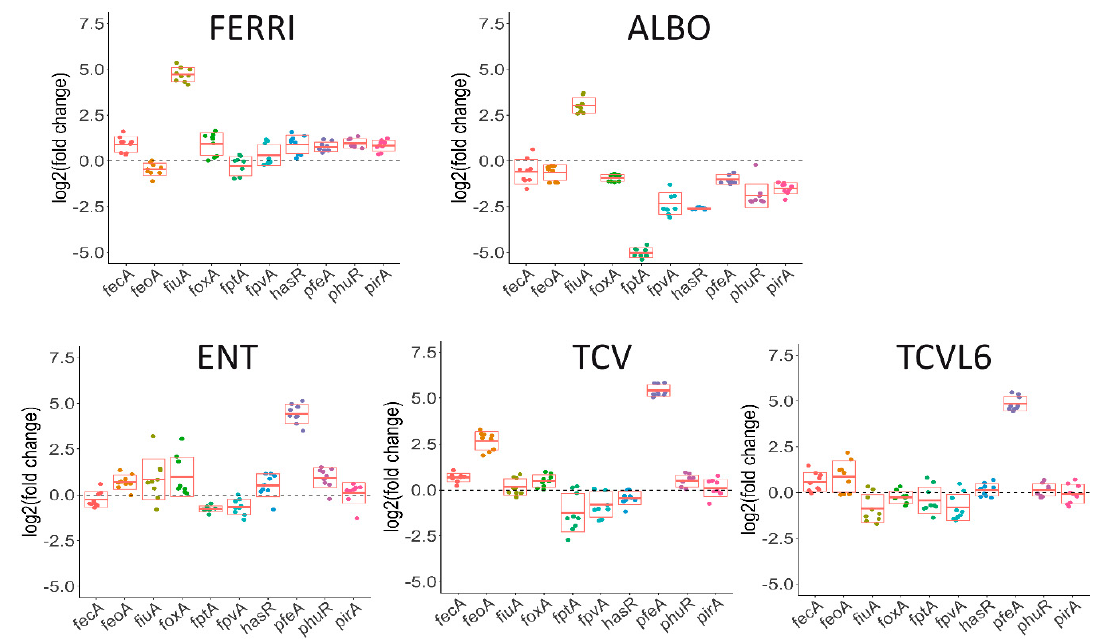
Figure 5. Analysis of changes in the expression of proteins involved in iron-uptake pathways in P. aeruginosa cells during A549 epithelial cell infection, in the presence or absence of ALBO, TCVL6, FERRI, ENT, or TCV. ( a , b ) Proteomic analyses were performed on P. aeruginosa PAO1 cells after a 3-h infection of A549 epithelial cells in RPMI medium, in the presence or absence of 10 µM ALBO or TCVL6. Median values measured in the infection assay supplemented with either 10 µM ALBO or TCVL6 were plotted against those measured in the infection assay in the absence of supplementation with siderophore–antibiotic compounds. The median values represent the median of the relative intensity of each protein normalized against all proteins detected by shotgun analysis (n = 5). In blue are OMTs, in yellow, proteins of the pyochelin (PCH) pathway and in green proteins of the PVD pathway. ( c – e ) Heat maps of OMTs ( c ), and various proteins involved in the PVD ( e ) and PCH ( d ) pathways. The darker the shade of blue, the higher the induced expression of the protein. The darker the shade of red, the higher the repressed expression of the proteins. Only the proteins for which a change in the level of expression was observed are shown. The nd note indicates that the protein has not been identified, ns indicates that the p -value is higher than 0.05; the *, ** and *** symbols indicates a p -value lower than 0.05, 0.01 and 0.001 respectively. All siderophore or siderophore–antibiotic compounds were added at 10 µm.